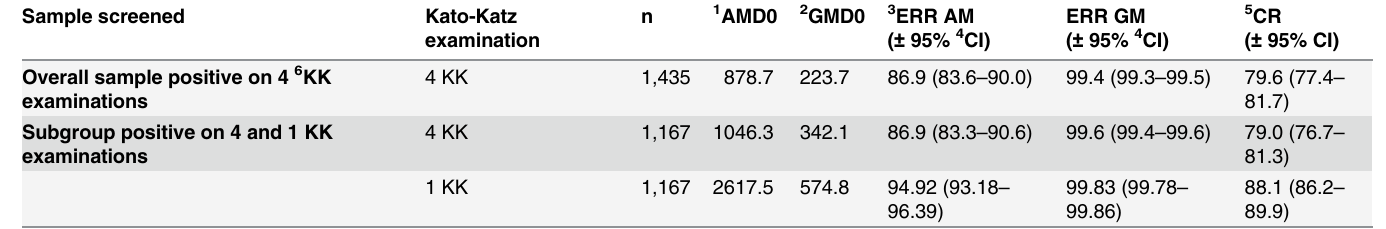
Table 4. Drug efficacy outcomes at baseline in individuals detected positive for S . mansoni by a single or quadruplicate Kato-Katz thick smear examinations at baseline. Sample